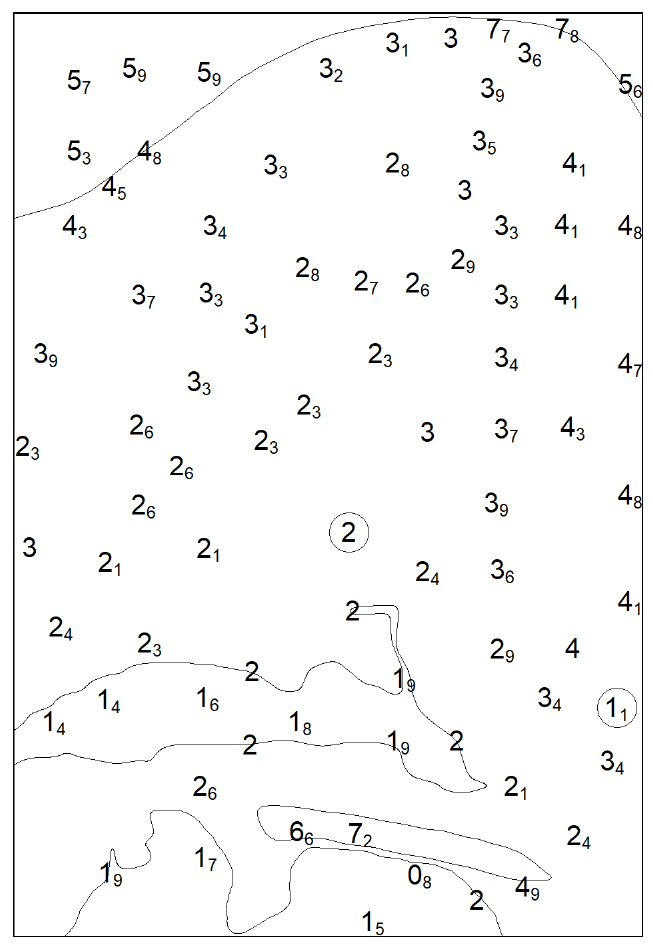
Figure 11. Extract from the 1:20 K scale chart (depth contours 2, 5, 10 m).